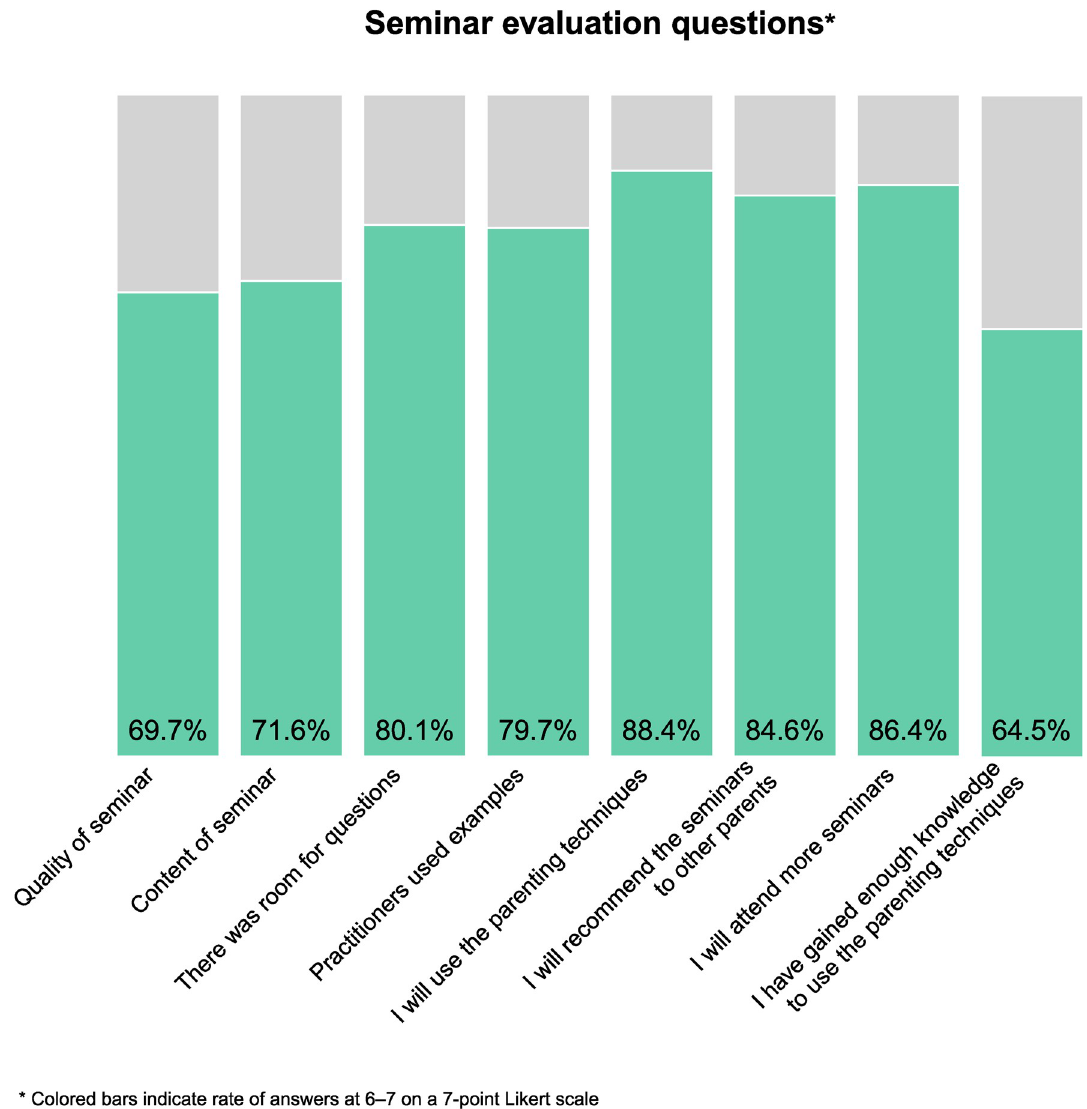
Fig 4. Percentage stacked bar charts of evaluative questions from